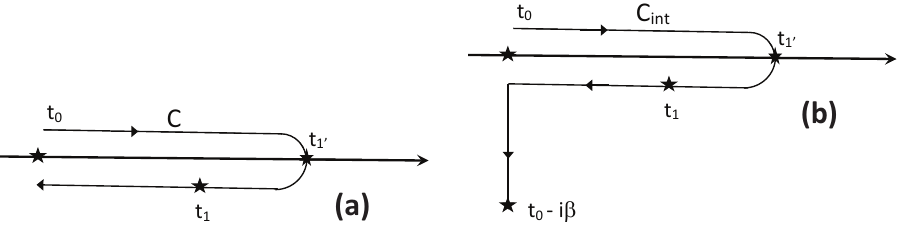
Figure 1. ( a ) Sketch of the “closed path” contour C; ( b ) Sketch of the “interaction” contour C int .